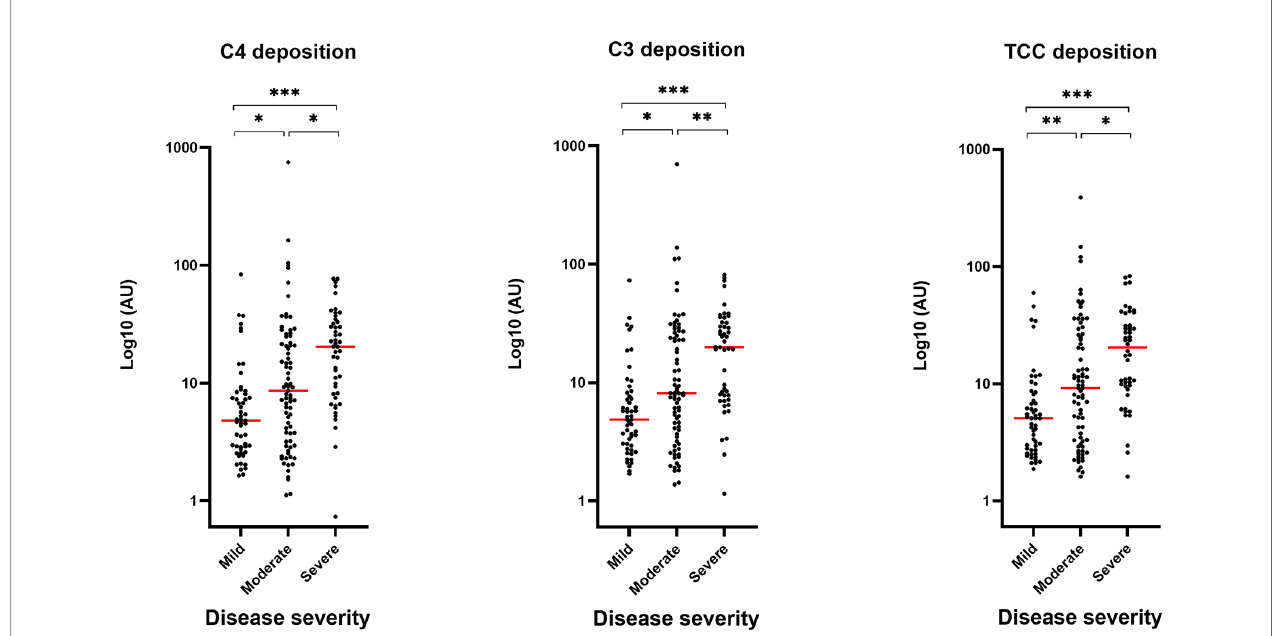
FIGURE 3 | Correlation between complement deposition, IgG levels and severity. Groups divided according to disease severity. Dynamic range represented in arbitrary units (AU). A p value < 0.05 was considered signi fi cant. *p < 0.05, **p < 0.01, ***p < 0.001 using Tukey all-pair comparisons, n =